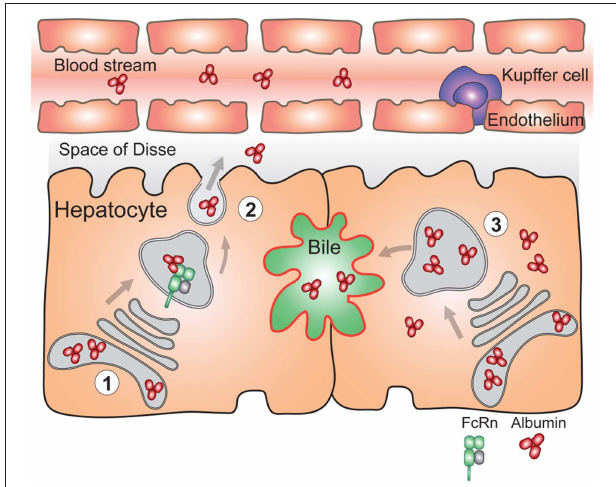
FIGURE 4 | FcRn in the liver is essential for vectorial delivery of albumin into the blood stream. (1) Hepatocytes are polarized epithelial cells of which the apical side (red) faces the bile duct, and the basolateral side (black) faces the fenestrated sinusoidal endothelium. The sinusoidal endothelium is populated by liver specific macrophages called Kupffer cells. Albumin is produced solely by hepatocytes. (2) FcRn in hepatocytes is required for delivery of newly synthesized albumin to the basolateral side of the cells, and subsequent secretion of albumin to the blood stream (left) (3) Absence of FcRn expression in hepatocytes results in increased albumin levels in the bile, its intracellular accumulation and lower circulating albumin levels (right). For simplicity, FcRn-mediated albumin recycling in hepatocytes is not